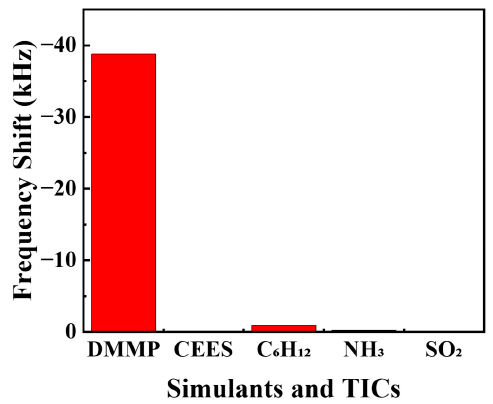
Figure 10. Selectivity for CWAs simulants and TICs of PSS-TU3.